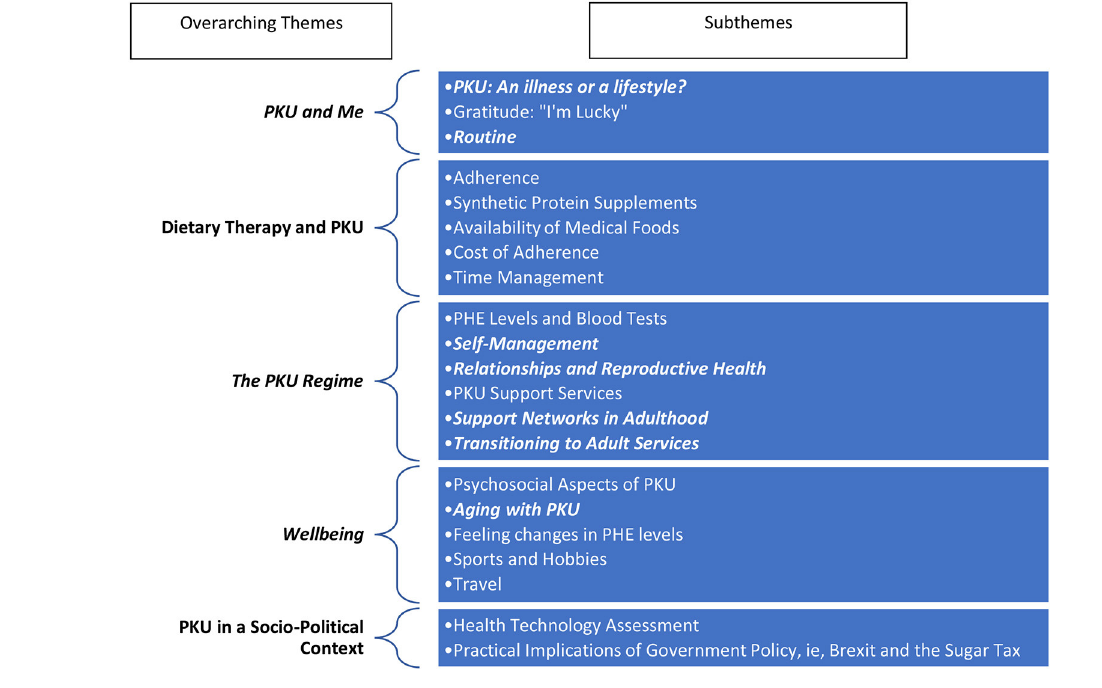
TABLE 3 Overall study findings, overarching themes and subthemes *